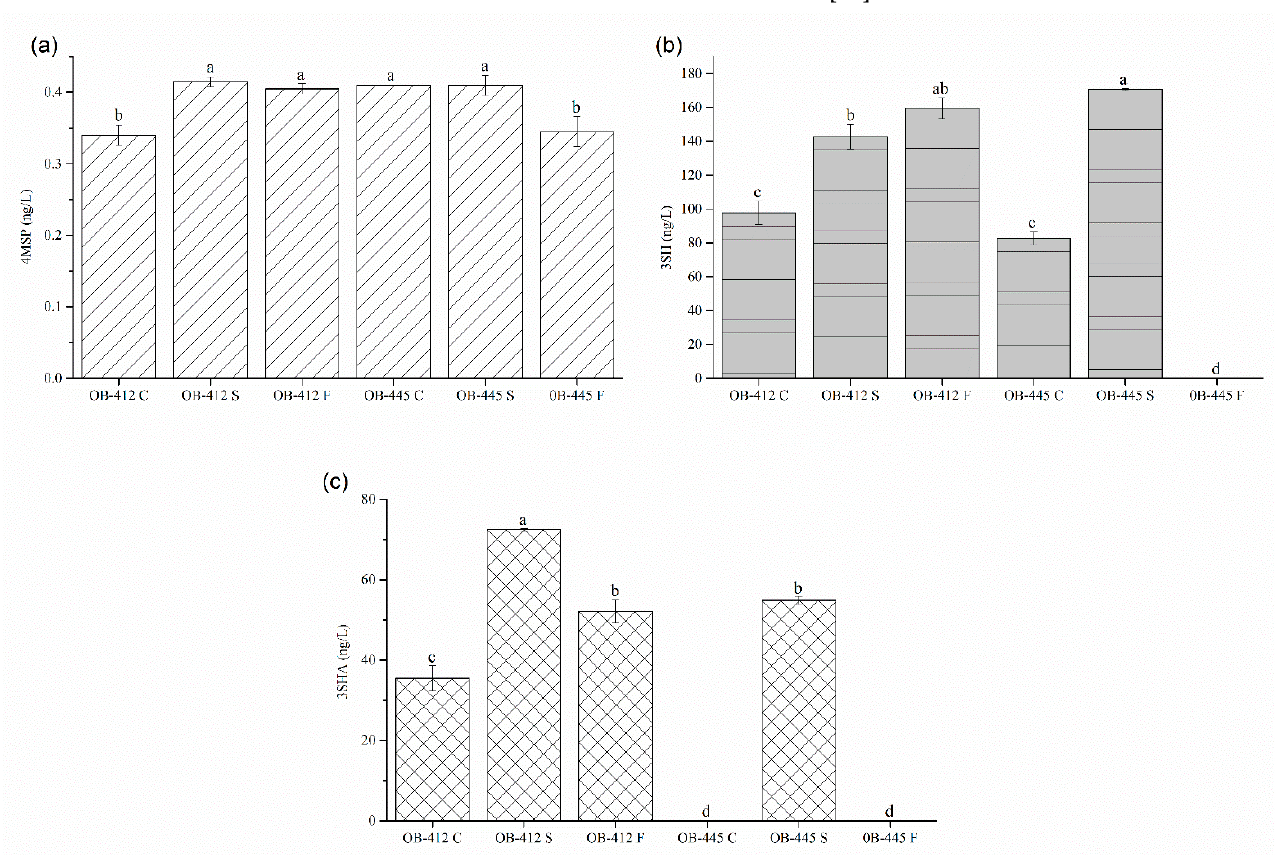
Figure 1. Concentrations of varietal thiols in analyzed Graševina wines: ( a ) 4MSP ( b ) 3SH and ( c ) 3SHA. Different letters indicate significant differences between wines (Tukey’s test, p < 0.05). Ab- breviations: OB-412 and OB-445 represent the two grape clones used; C- control variant, fermentation with S. cerevisiae Lalvin Sensy; S- fermentation with S. cereviasiae Sauvy yeast; and F- sequential fermentation of M. pulcherrima and S. cerevisiae .